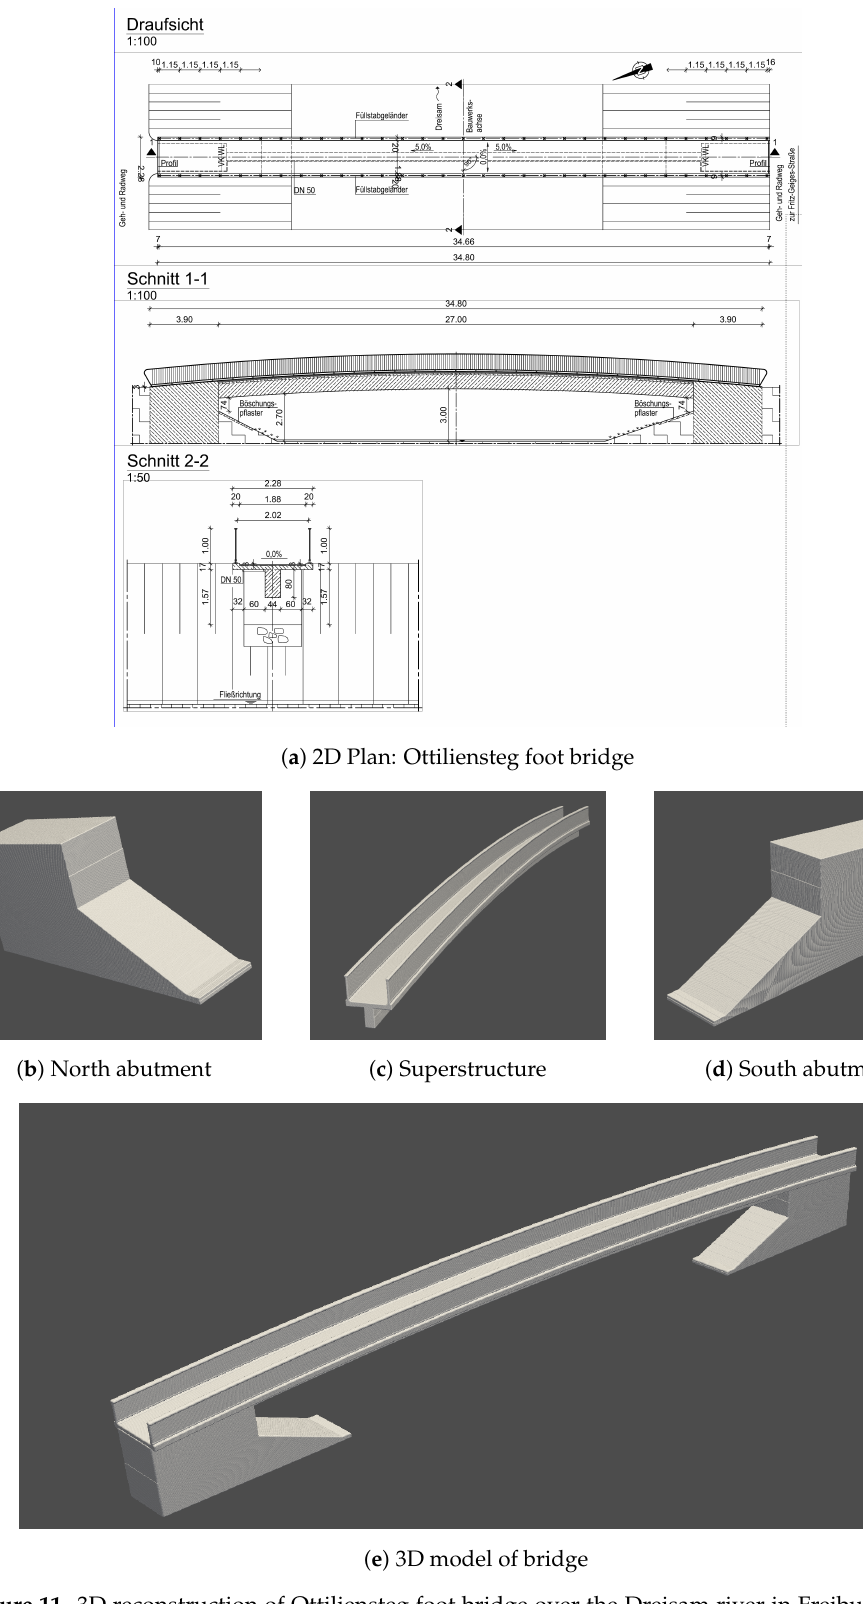
Figure 11. 3D reconstruction of Ottiliensteg foot bridge over the Dreisam river in Freiburg. ( a ) is the 2D plan used to reconstruct the parts of the 3D model. ( c ) is a 3D reconstruction of the concrete superstructure of the bridge. ( b , d ) is a 3D reconstruction of north and south abutments of the bridge. ( e ) shows the fused parts of the reconstructed 3D model of the Ottiliensteg foot